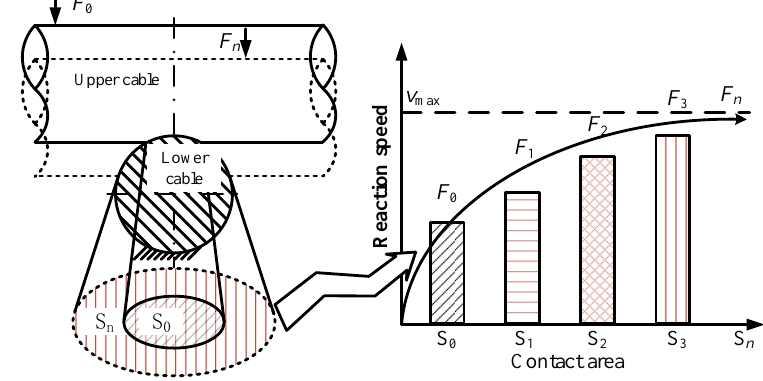
Figure 7. The change of frictional contact area and the corresponding reaction